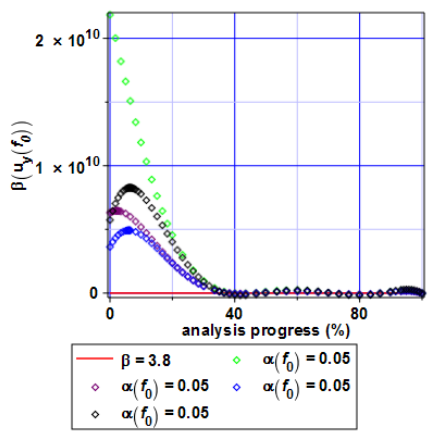
Figure 27. Reliability index for the serviceability limit state (extreme vertical displacement) for the beam.